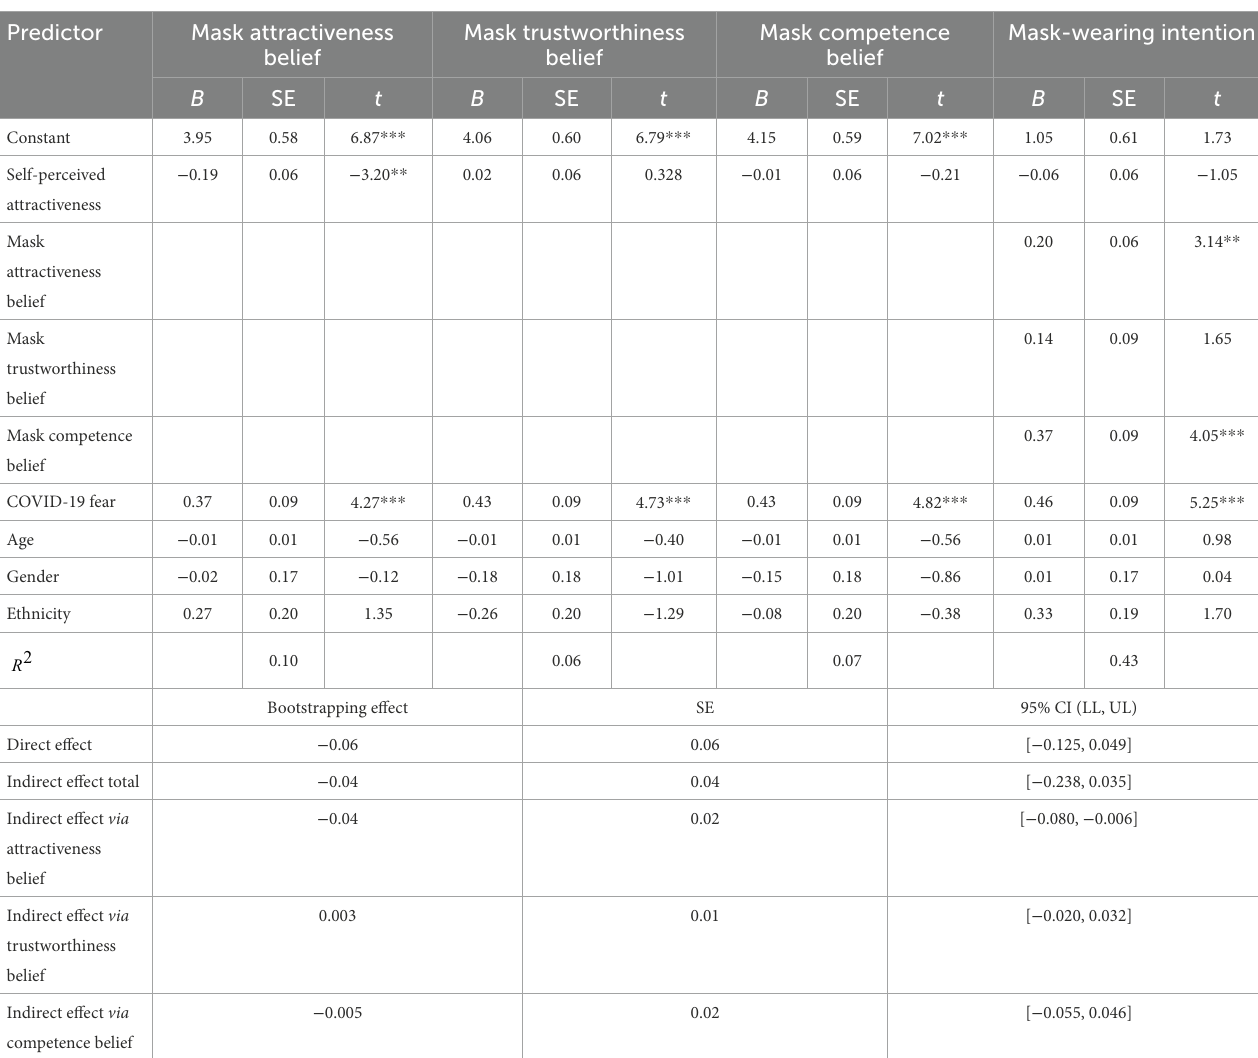
TABLE 2 Regression results for parallel mediation in Study 2. Predictor Mask attractiveness